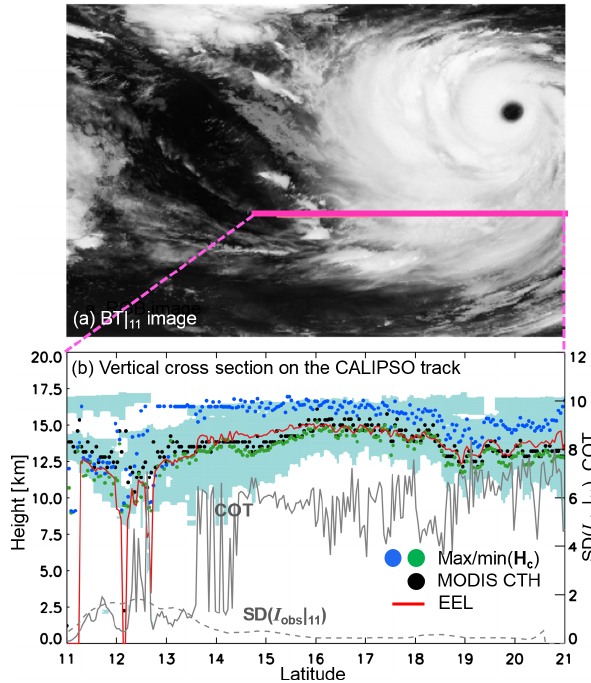
Figure 7. (a) BT | 11 image from MODIS (MYD021 C6) at 15:30UTC on 19 August 2015. This scene captures part of Ty- phoon Goni. The heavy pink line on the BT | 11 image shows the CALIPSO track the closest to MODIS observation time. (b) Ver- tical cross section of the CALIPSO track designated by the heavy pink line in Fig. 7a. The vertical feature mask is shown as sky-blue contours (randomly and horizontally oriented ice). The red solid line shows where the layer COT (integrated Q e at 532nm from CALIOP) reaches a value of 0.5. The green–blue and black cir- cles are the min–max( H c ) and MODIS CTH, respectively. The gray solid (dashed) line on the right-side y axis is the column COT from CALIOP (standard deviation of 11µm radiances from